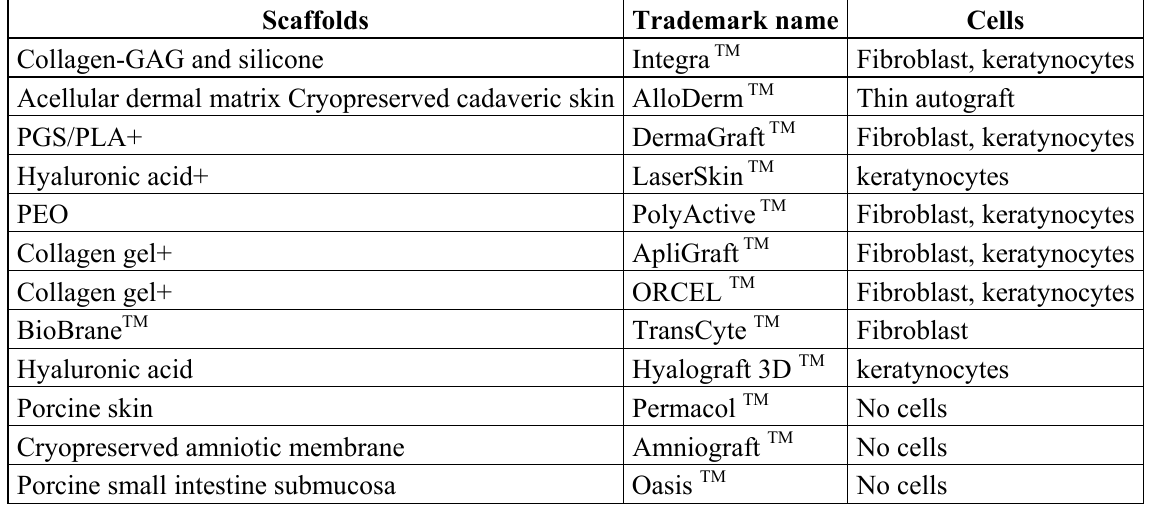
Table 1. Table of scaffolds that are currently widely used in clinical